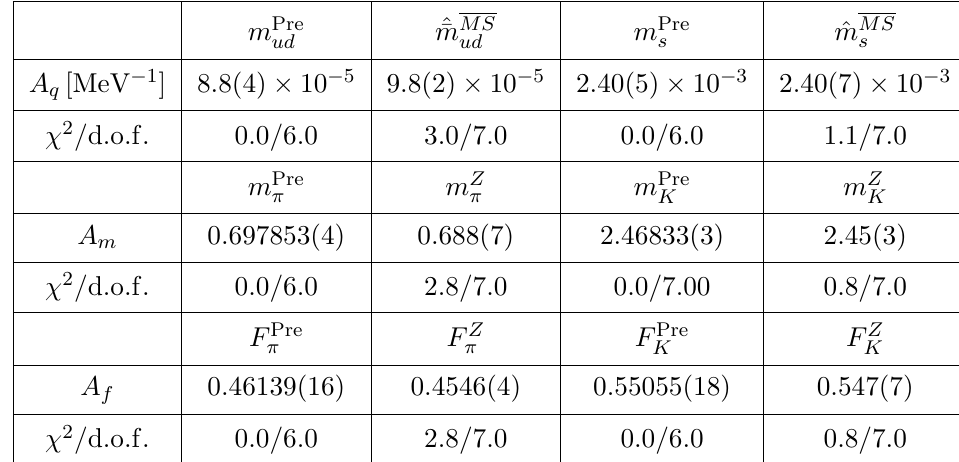
Table 20 . Comparisons of the (cid:12)tting results of the slopes A q (upper), A m (middle), and A f (lower) with the predictions.